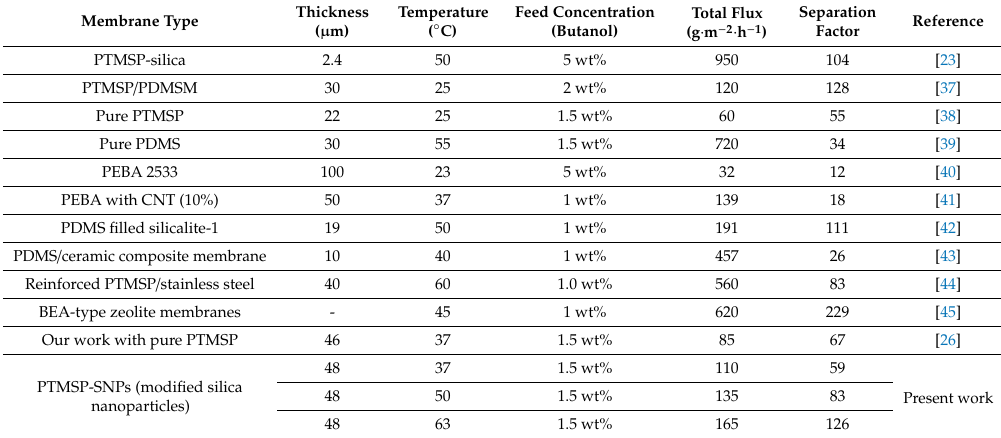
Table 1. Comparison of di ff erent membranes using butanol-water mixtures by pervaporation process.